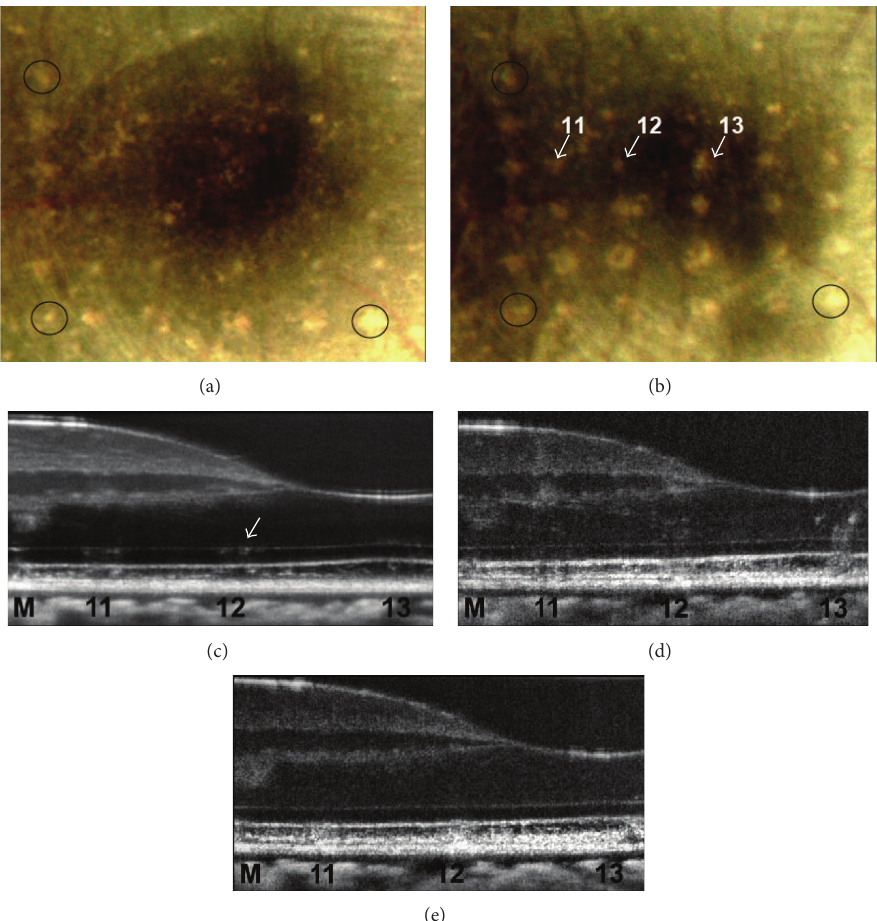
Figure9:FundusandOCTB-scansof413nmexposuresintheretinaofonesubject.(a)Lesions11–13(474J/cm 2 )werenotpositivelyidentified as MVLs in color fundus photos at the 1-hour observation point. (b) At the 24-hour observation point, all three exposure sites were positively identified as a MVL. OCT B-scans collected within minutes of the initial exposure (c) reveal a hyperreflective “clumping” in the photoreceptor inner segment layer. The RPE layer shows a modest increase in reflectance with a “granular” appearance. (d) The damage surrounding the RPE and photoreceptors becomes more distinguishable 24 hours later. A wispy “threading” at the boundary of the inner nuclear layer (INL) and outer plexiform layer (OPL) for lesions 11 and 12 becomes observable. An increased reflectance of the inner retinal layers directly above the lesion site suggests an edematous reaction. Nine days later, (e) the damage appears more homogenous and extends from its base at the RPE into the connecting cilia of the